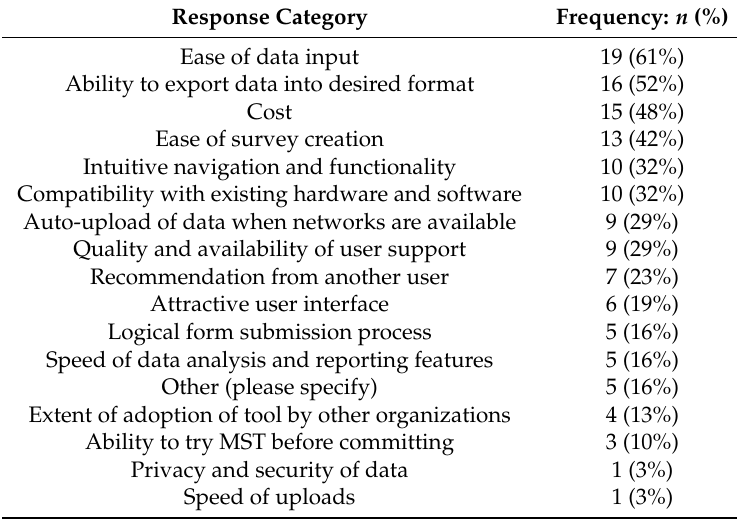
Table 4. Reason for selecting current